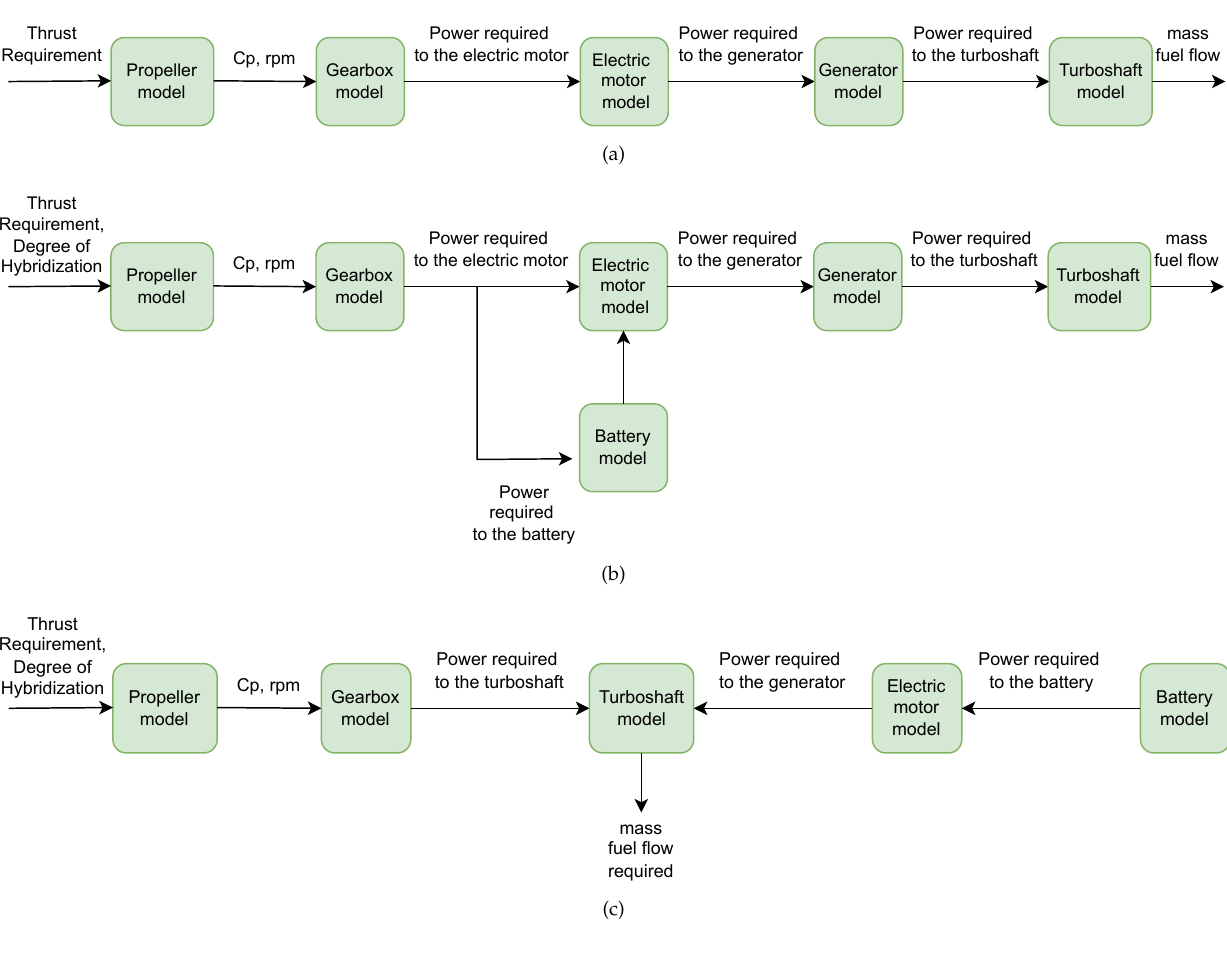
Figure 4. Flowchart of the implemented MATLAB models for the turboelectric ( a ), series ( b ), and parallel ( c ) hybrid-electric